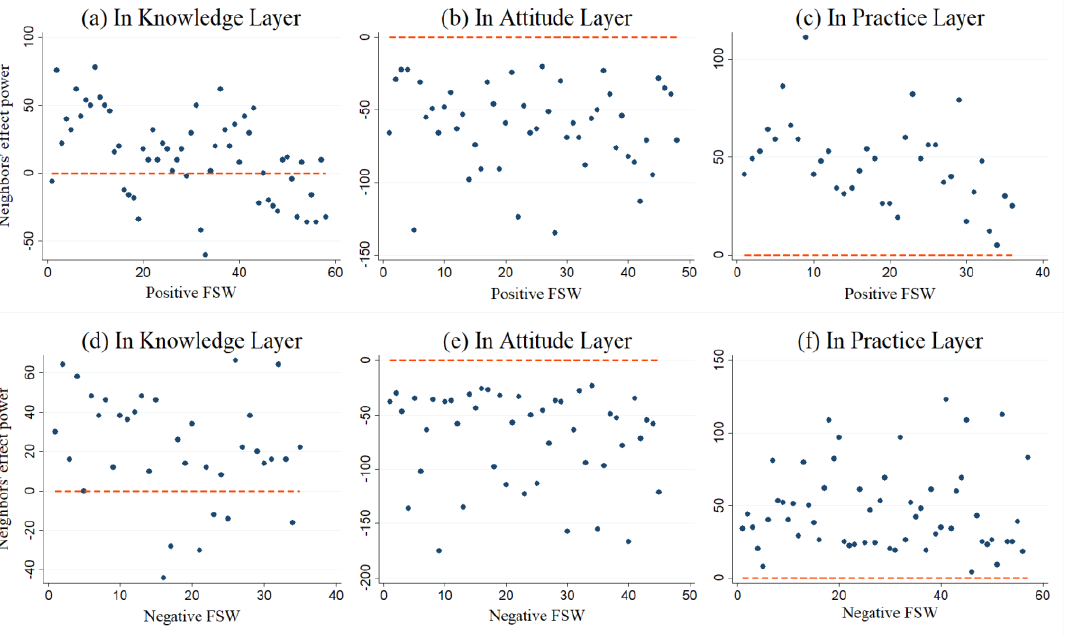
[ α ] of FSW i . i [ α ] = i